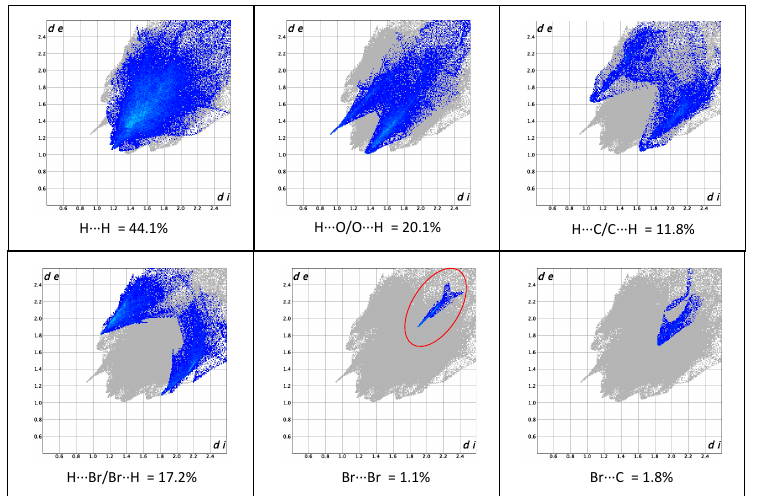
Figure 7. Fingerprint plots for 1a , delineated into H···H, O···H/H···O, C···H/H···C, Br···H/H···Br, Br···Br and Br···C contacts.